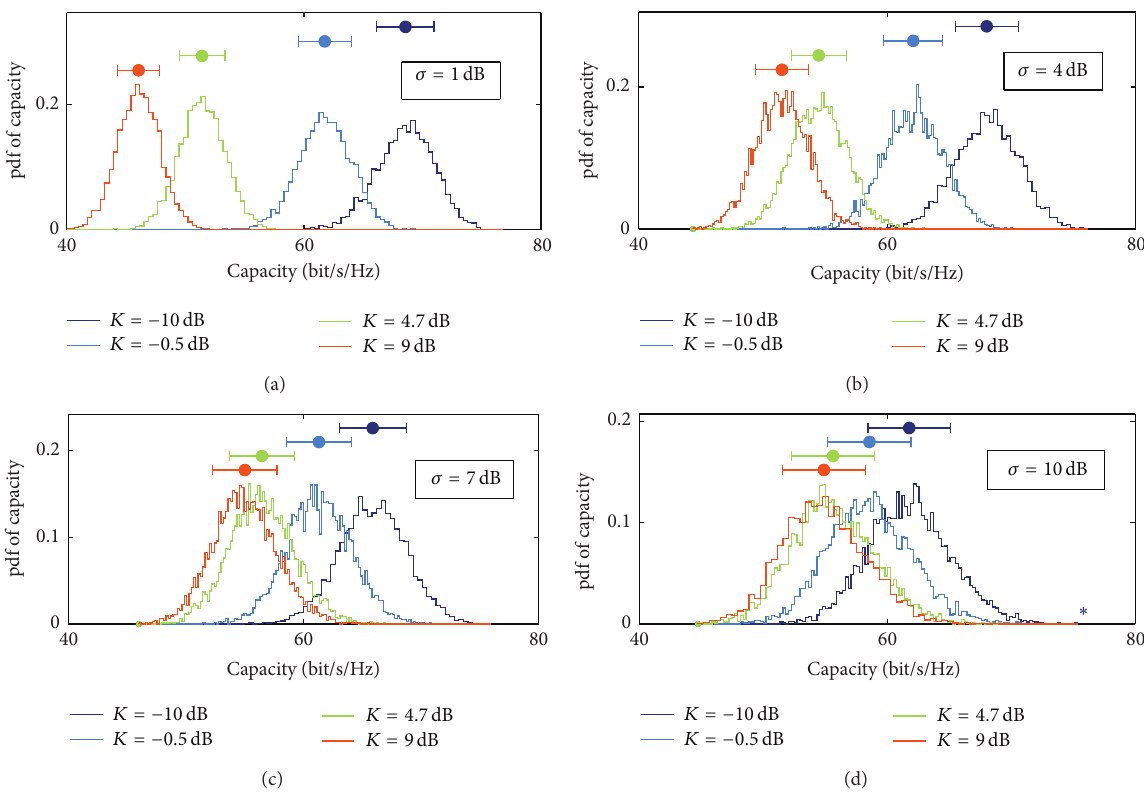
Figure 10: Probability density function of capacity versus capacity for the 8 × 8 MIMO system, (a) with SNR = 30 dB and 𝜎 = 1 dB, (b) 𝜎 = 4 dB, (c) 𝜎 = 7 dB, and (d) 𝜎 = 10